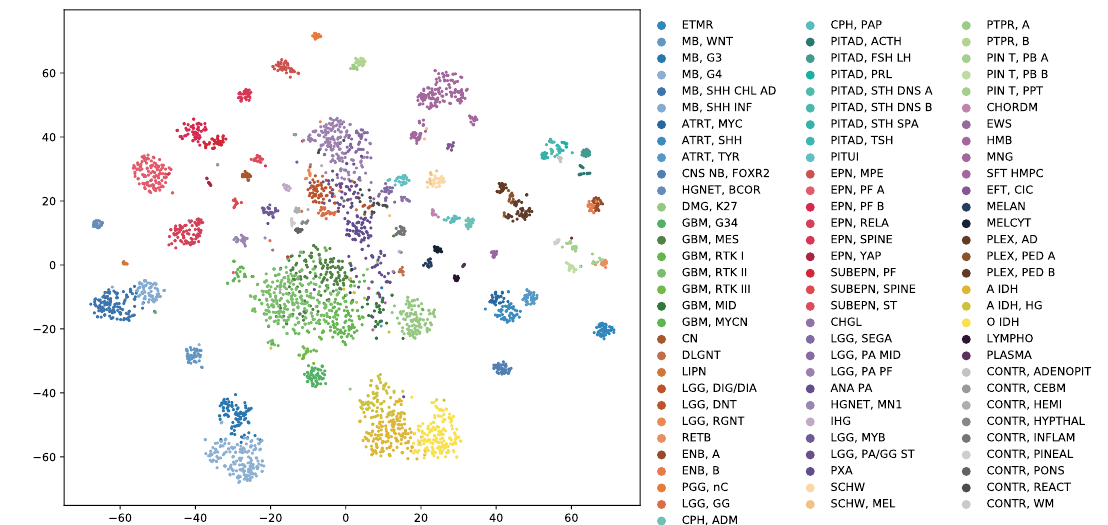
Figure 2. The 128D latent space of the BTM dataset learnt by the unsupervised phase of OmiEmbed. The scatter graph was visualised using t-SNE. Each label in the scatter graph was coloured by its methylation class label and the full name of each class abbreviation can be found in Supplementary Table S2. Tumour types belonging to the same upper-level class were marked in similar colours.